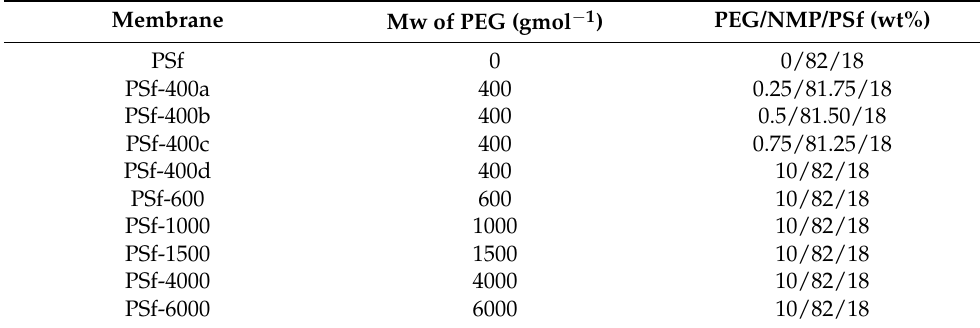
Table 1. Composition of casting solutions used in the fabrication of membranes’ substrates. Membrane Mw of PEG (gmol − 1